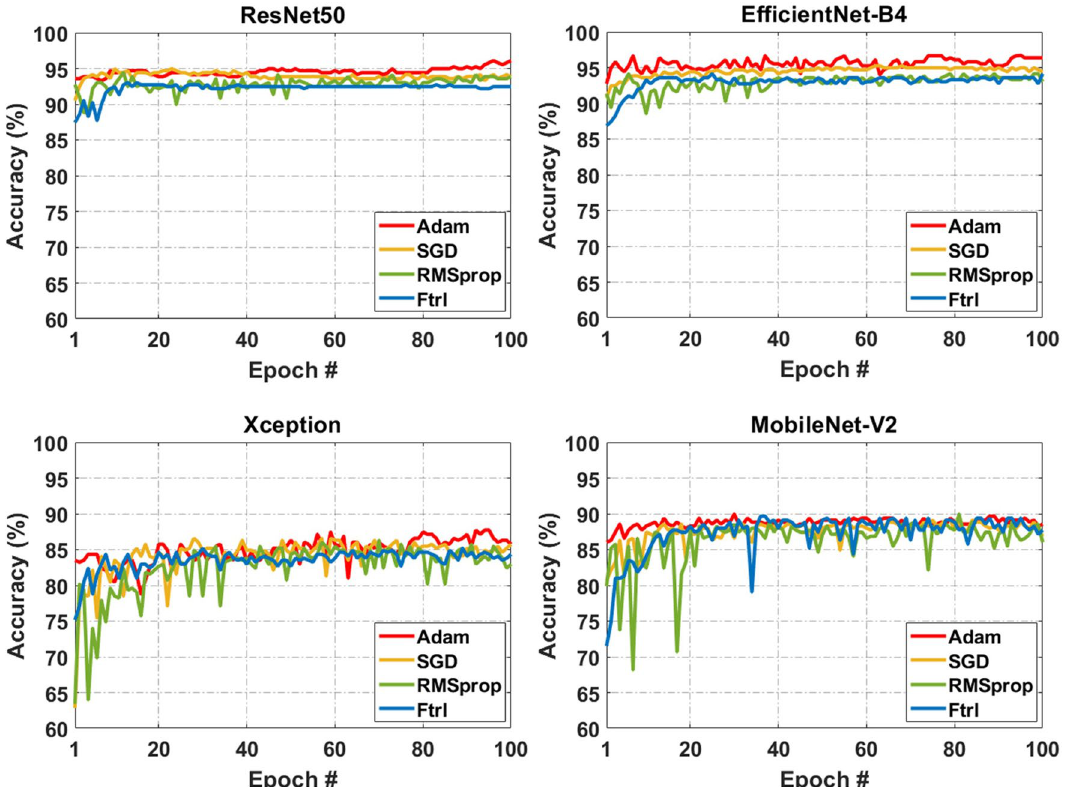
Figure 1. The effect of Adaptive Moment Estimation (Adam), Follow The Regularized Leader (Ftrl), Stochastic Gradient Descent (SGD), and Root Mean Square Propagation (RMSprop) optimizers with the learning rate of 0.001 on the accuracy of residual networks (ResNet), Xception, EfficientNetB4, and MobileNetV2 pre-trained conventional neural network (CNN) models using different epoch